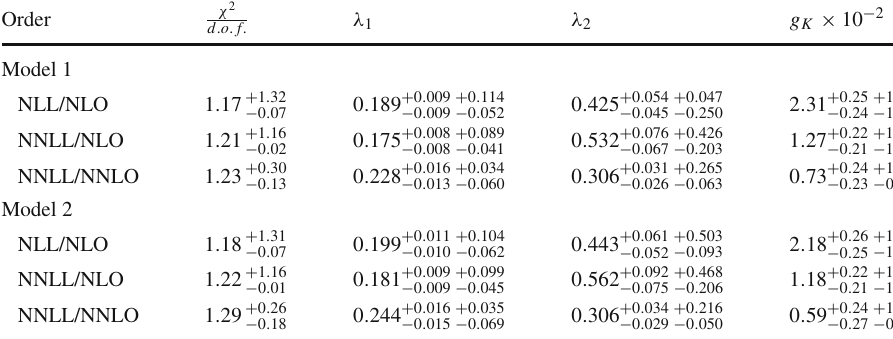
Table 13 The results of the χ 2 -minimization procedure with non-zero g K . The values of χ 2 are given with theoretical error-band. The values of extracted parameters are given with statistical error-band (the first pair of numbers) and the theoretical error-band (the second pair of numbers). The visual presentation of this table is given in Fig.